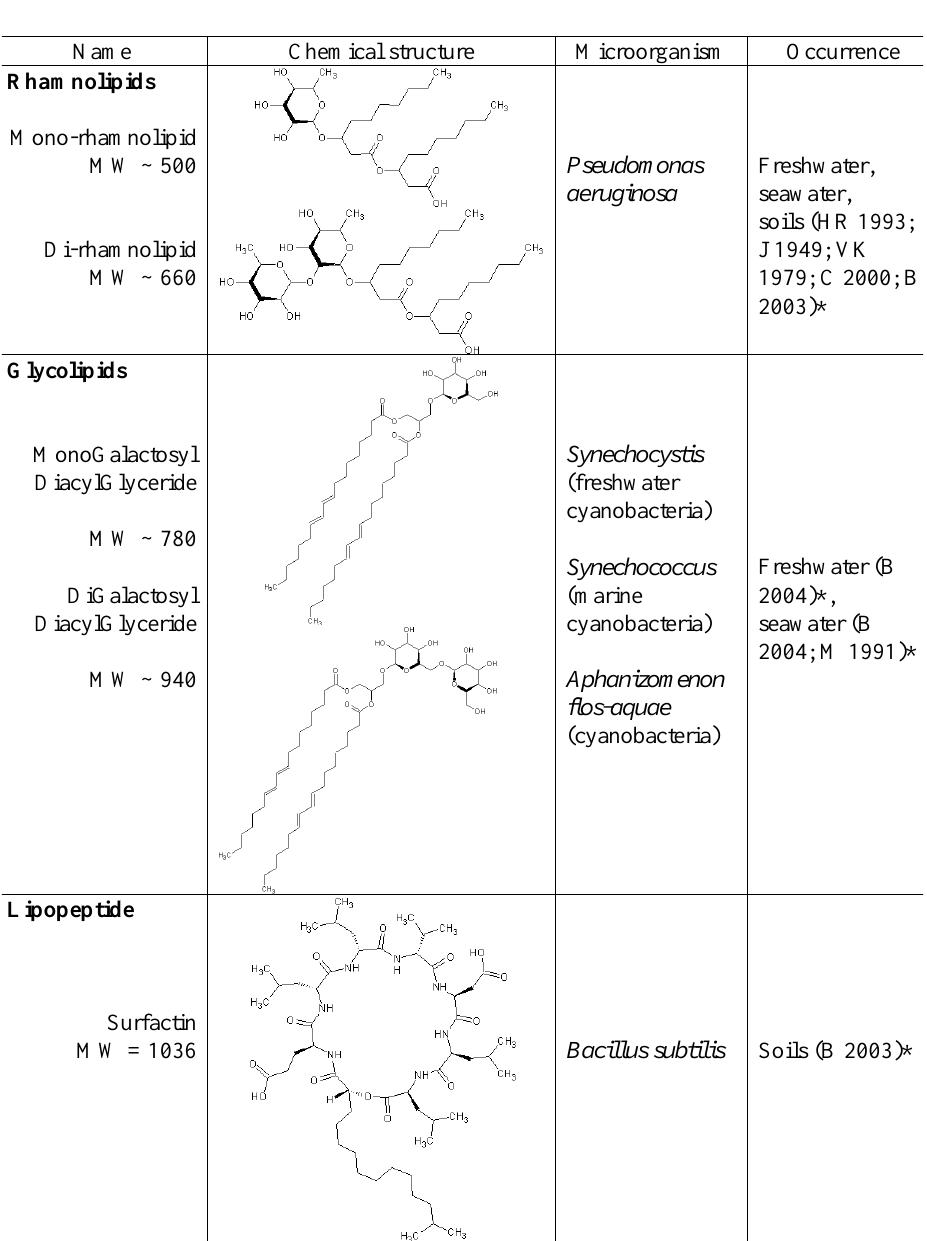
Table 1. Standard microbial substances studied in this work, and examples of microorganisms producing them and their occurrences in the